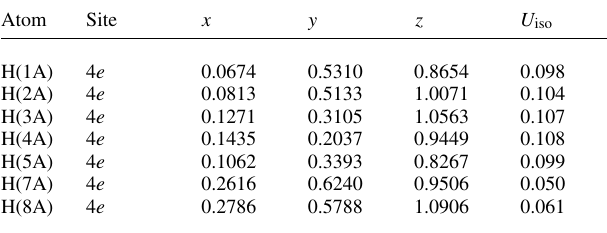
Table 2. Atomic coordinates and displacement parameters (in Å 2 ) .